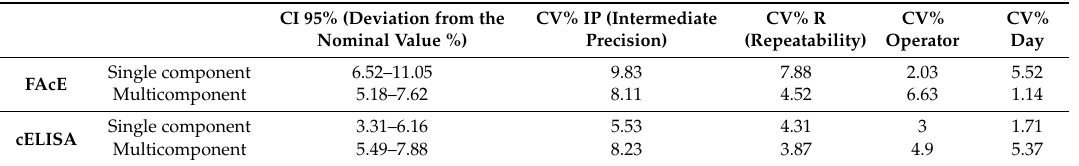
Table 4. Evaluation of accuracy and precision for FAcE and cELISA. CI, confidence interval; CV, coe ffi cient of